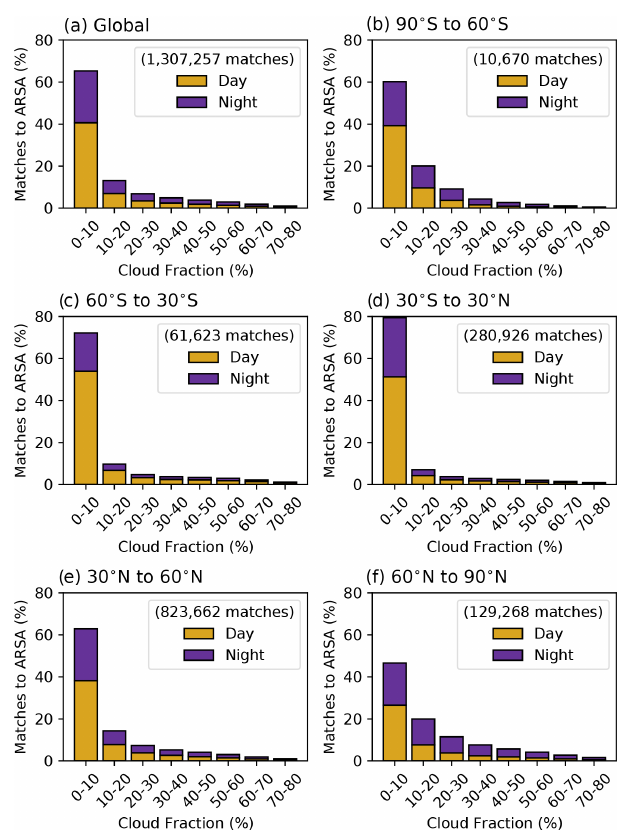
Figure 12. Like Fig. 9, binned sampling of IMS collocations over ARSA sites for global matches split into the five latitudinal bands used in this study. The total number of collocations is shown in the legend for each